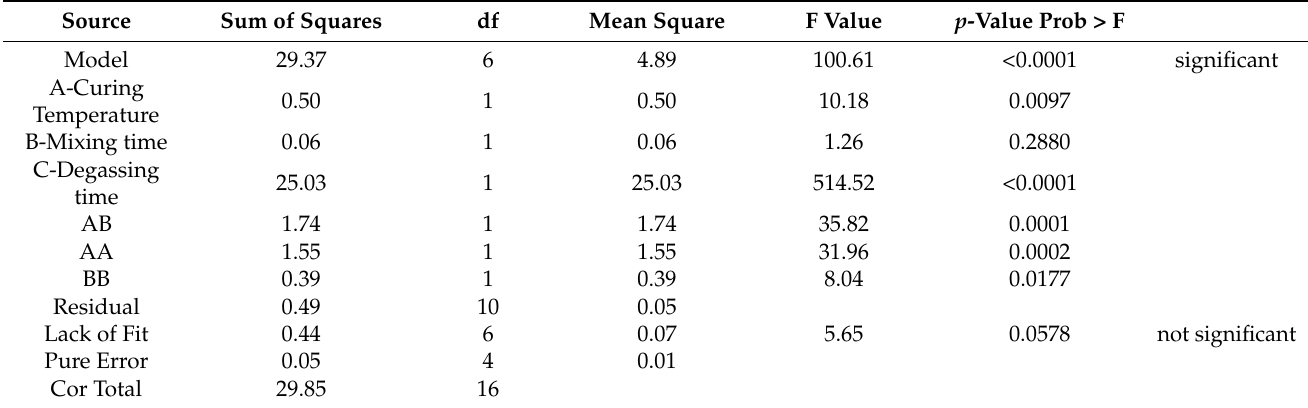
Table 6. Analysis of Variances (ANOVA) of Ra.